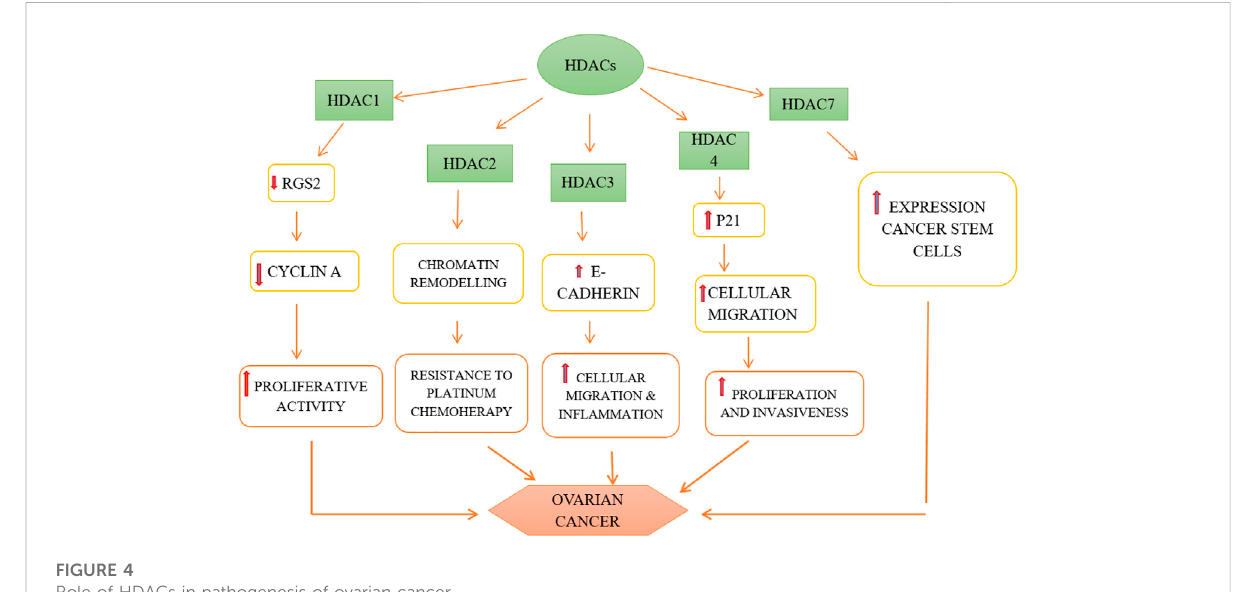
FIGURE 4 Role of HDACs in pathogenesis of ovarian cancer.